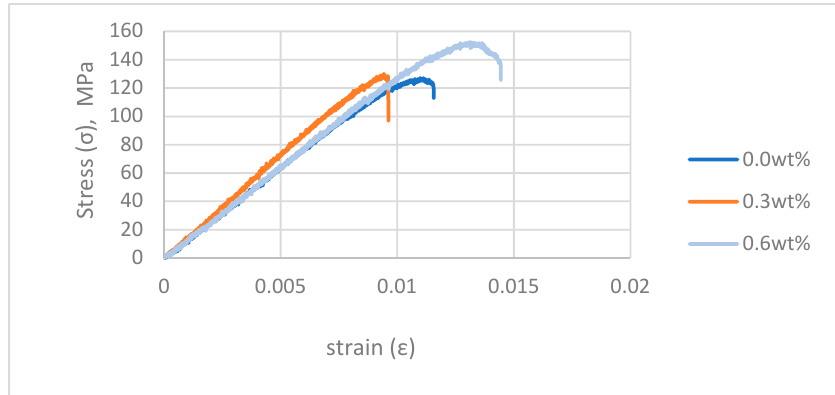
Figure 9. The representative stress–strain curves of 1 mm composites.